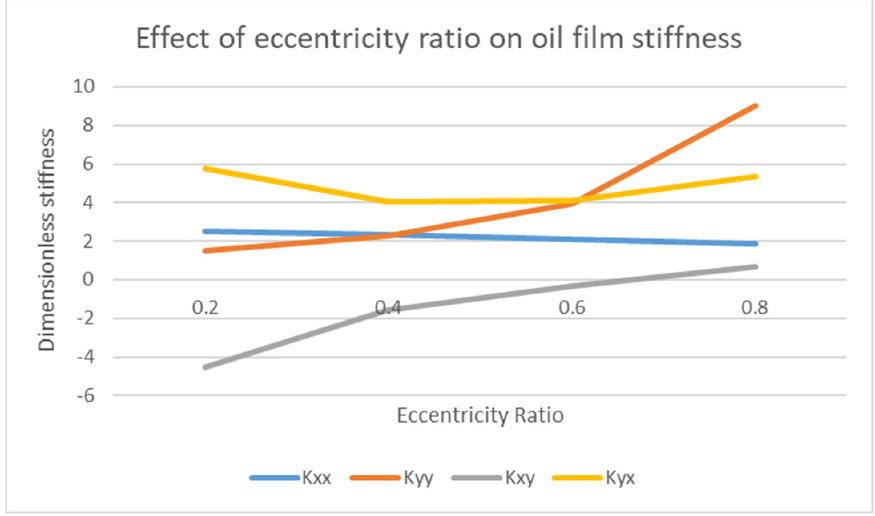
Figure 6. Effect of eccentricity ratio ε on dimensionless stiffness K .